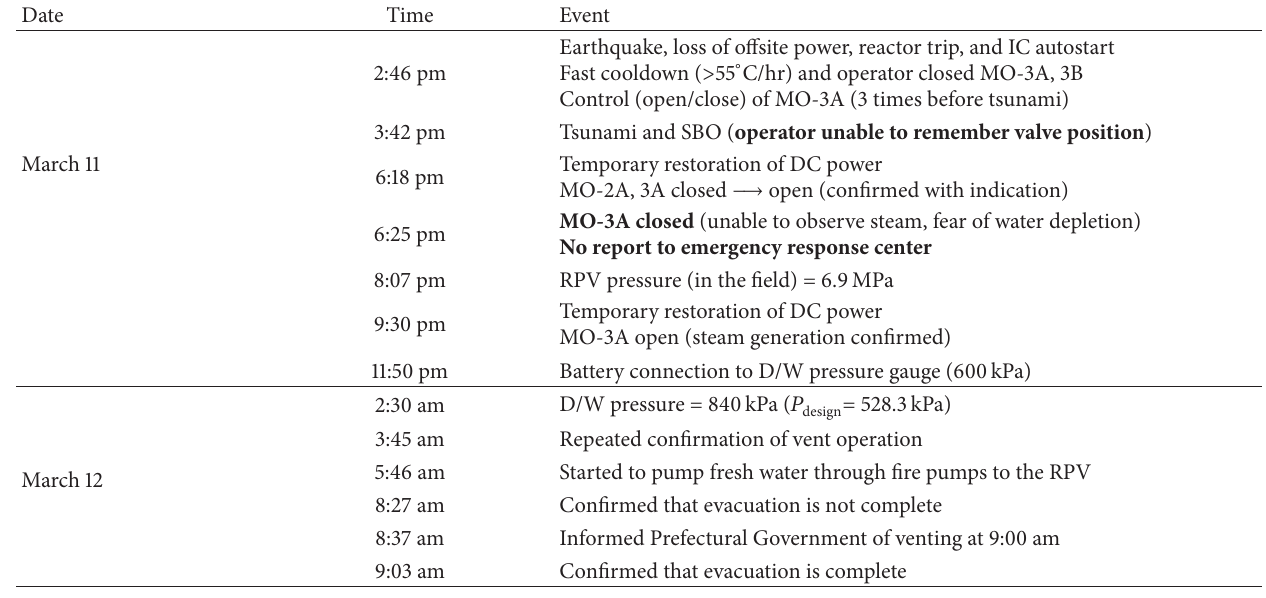
Table 2: Records related to the operation of the IC and venting in Unit 1.